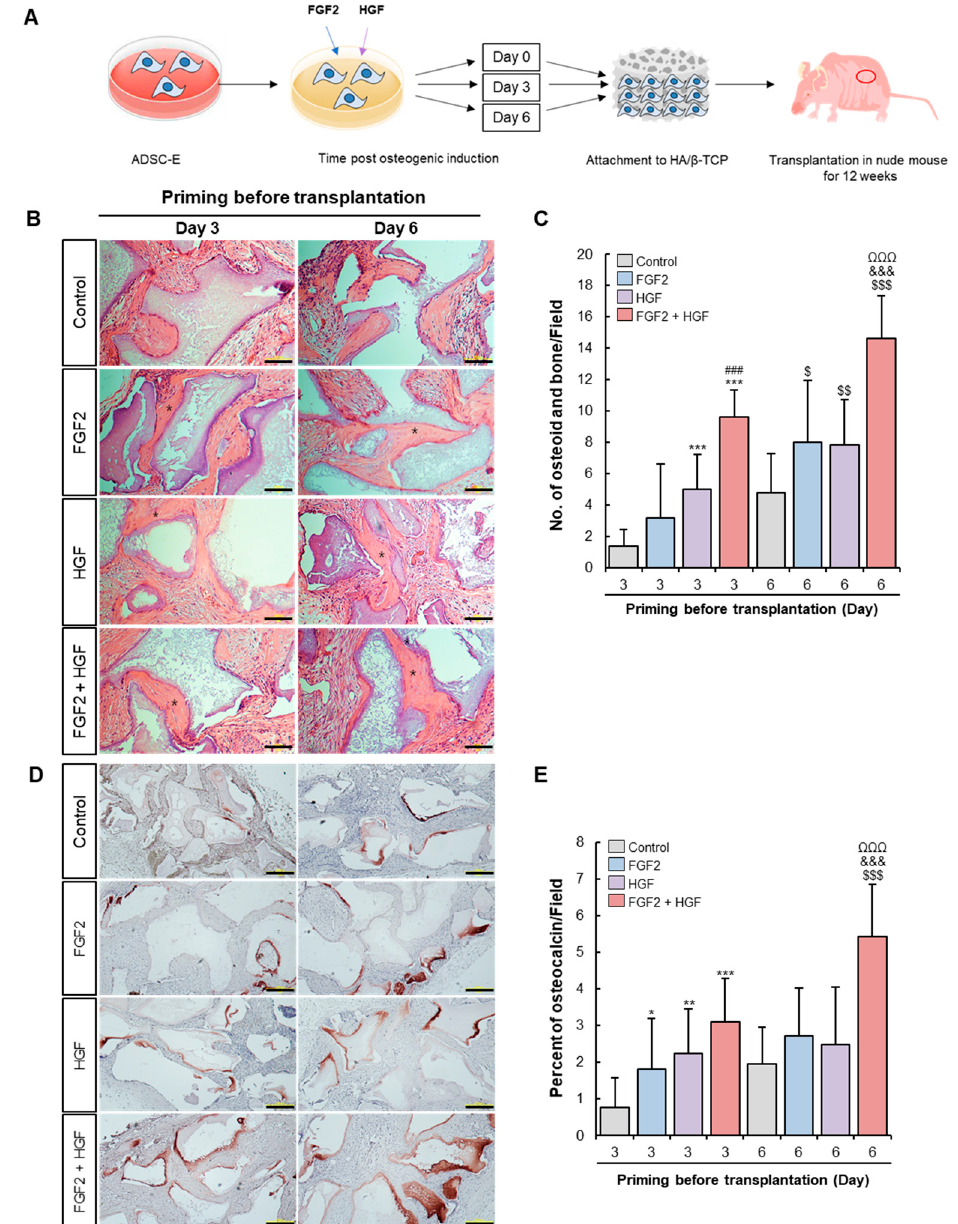
Figure 5. FGF-2 and HGF priming improve the bone forming capacity of ADSC-E in vivo . ( A ) Experimental design for cell transplantation of FGF-2 and/or HGF-primed ADSC-E. ( B , C ) H&E staining for the complex of transplanted cells and bone particles. Scale bar, 200 μ m. ( D , E ) Human osteocalcin stained immunohistochemically was quantified with ImageJ. Scale bar, 200 μ m. Results are shown as the mean ± SD of three replicate wells for each group. * p < 0.05, ** p < 0.01, *** p < 0.001 vs. Day 3 of control, ### p < 0.001 vs. Day 3 of HGF-primed ADSC-E, $ p < 0.05, $$ p < 0.01, $$$ p < 0.001 vs. Day 6 of control, &&& p < 0.001 vs. Day 6 of HGF-primed ADSC-E and ΩΩΩ p < 0.001 vs Day 3 of FGF2/HGF-primed ADSC-E.